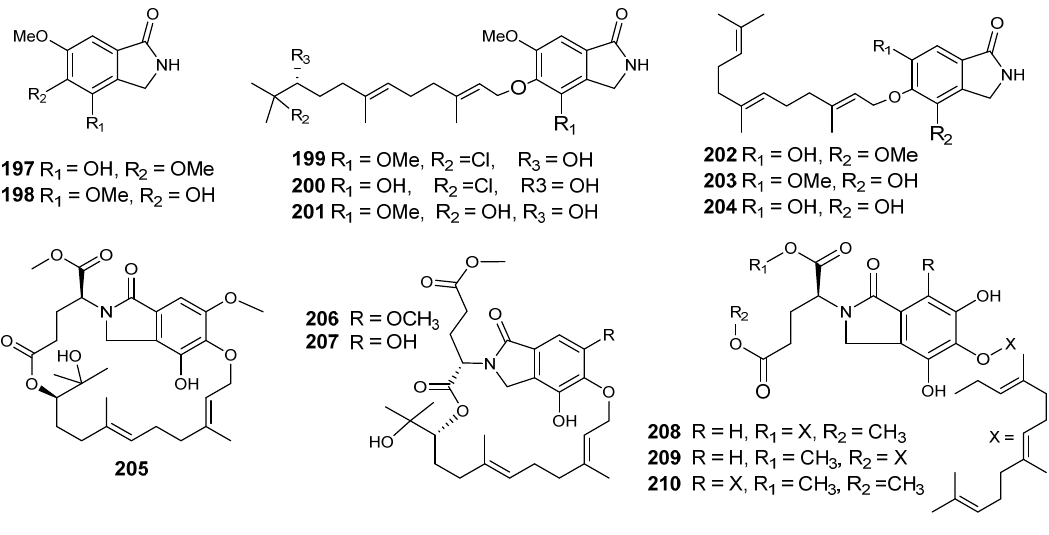
Figure 13. Structures of compounds 197–210.